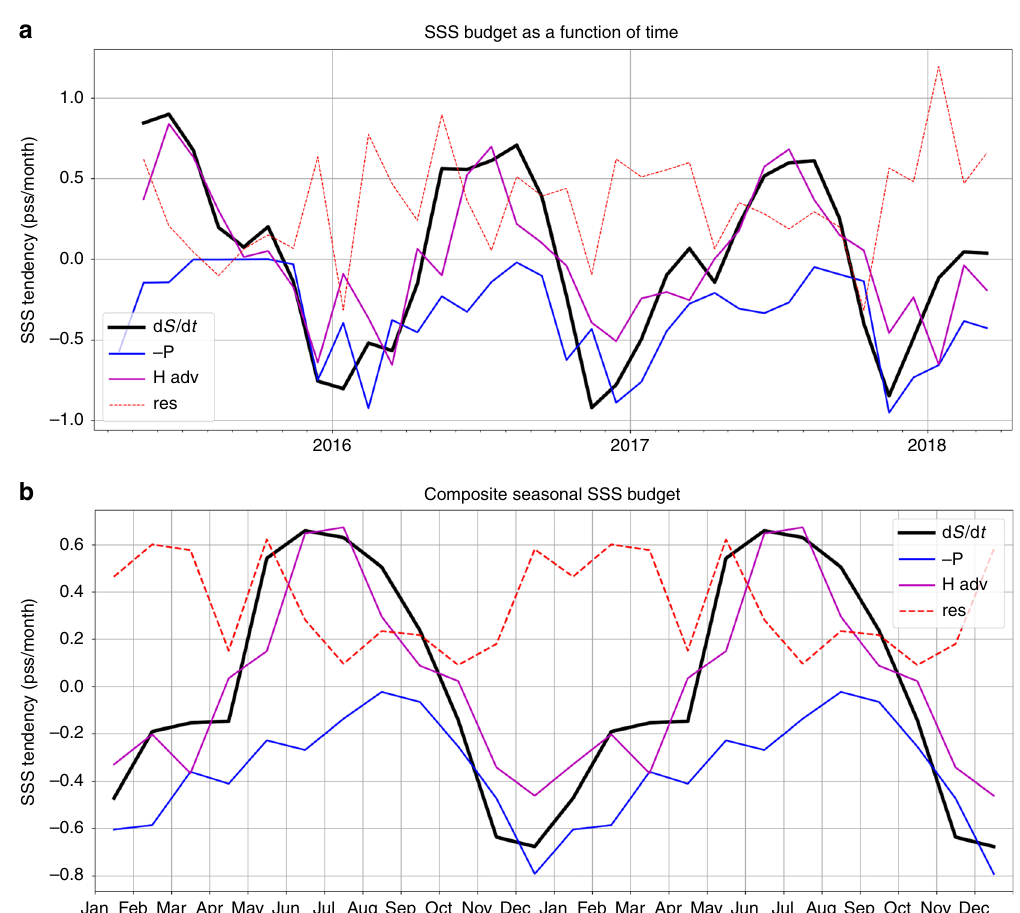
Fig. 7 Time series of sea surface salinity budgets for the Java Sea and the averaged seasonal cycle. a Budget terms for the 3-year period of the study. b Seasonal cycles by averaging the values of the same month from different years. The seasonal cycles were plotted twice to facilitate the visualization. Black curves indicate the observed sea surface salinity tendencies. The blue, magenta, and red dashed curves represent the contributions by precipitation, horizontal advection, and the residual,